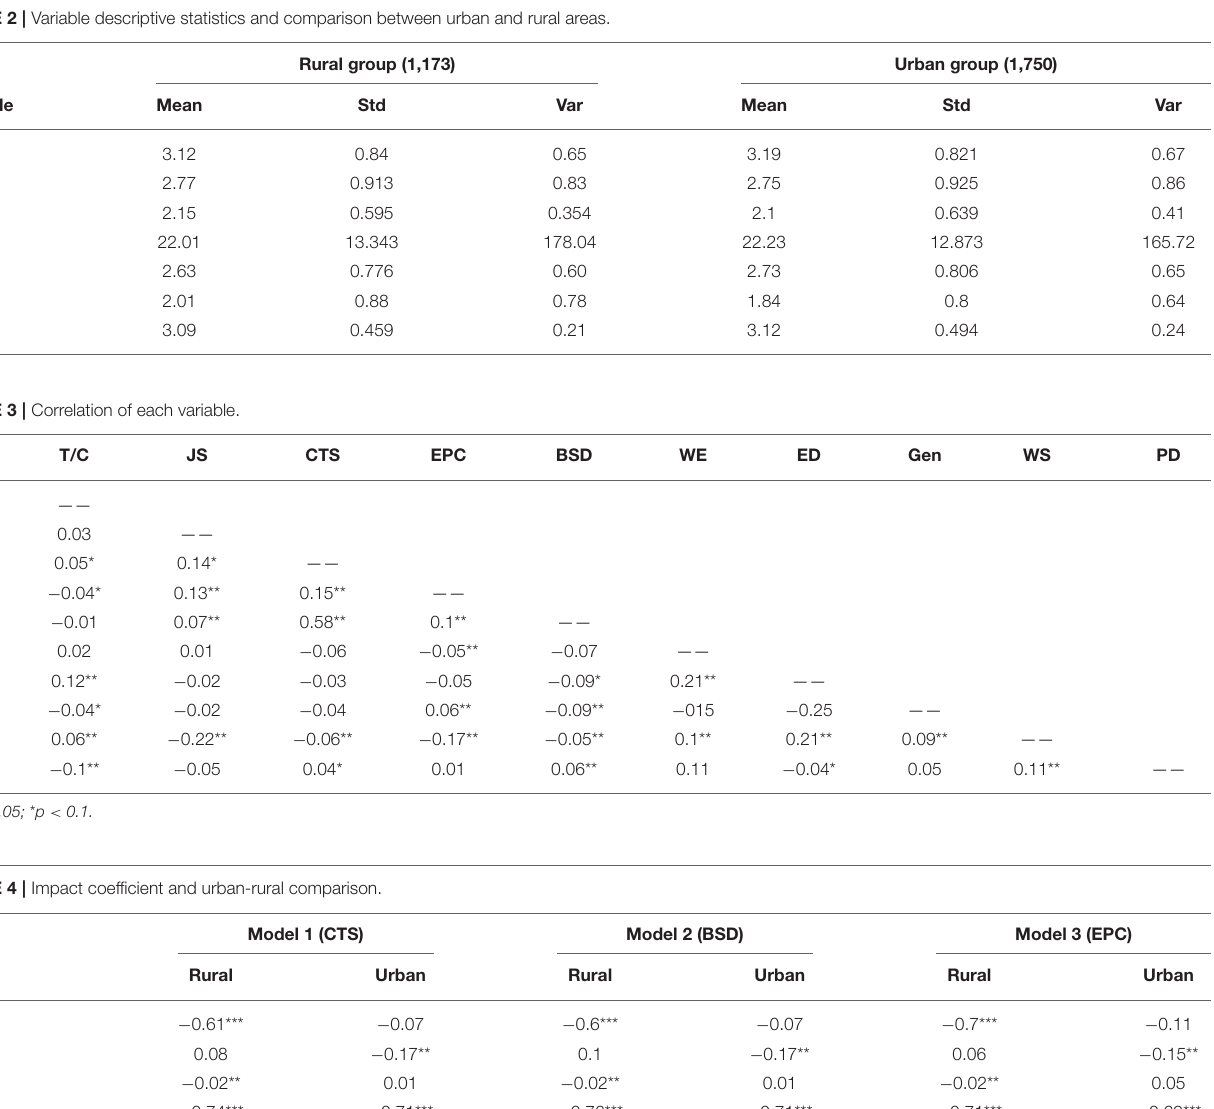
TABLE 2 | Variable descriptive statistics and comparison between urban and rural areas. Rural group (1,173) Urban group (1,750)